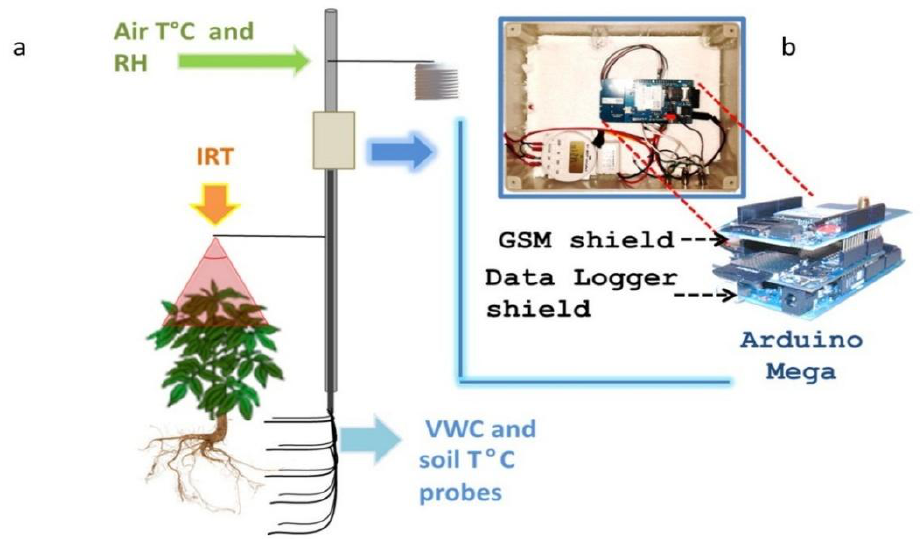
Figure 2. Platform architecture: ( a ) schematic representation of a measurement unit; ( b ) (inset) electronic components inside the indoor enclosure (top-view) and magnification of the micro-controller board and the superimposable expansion